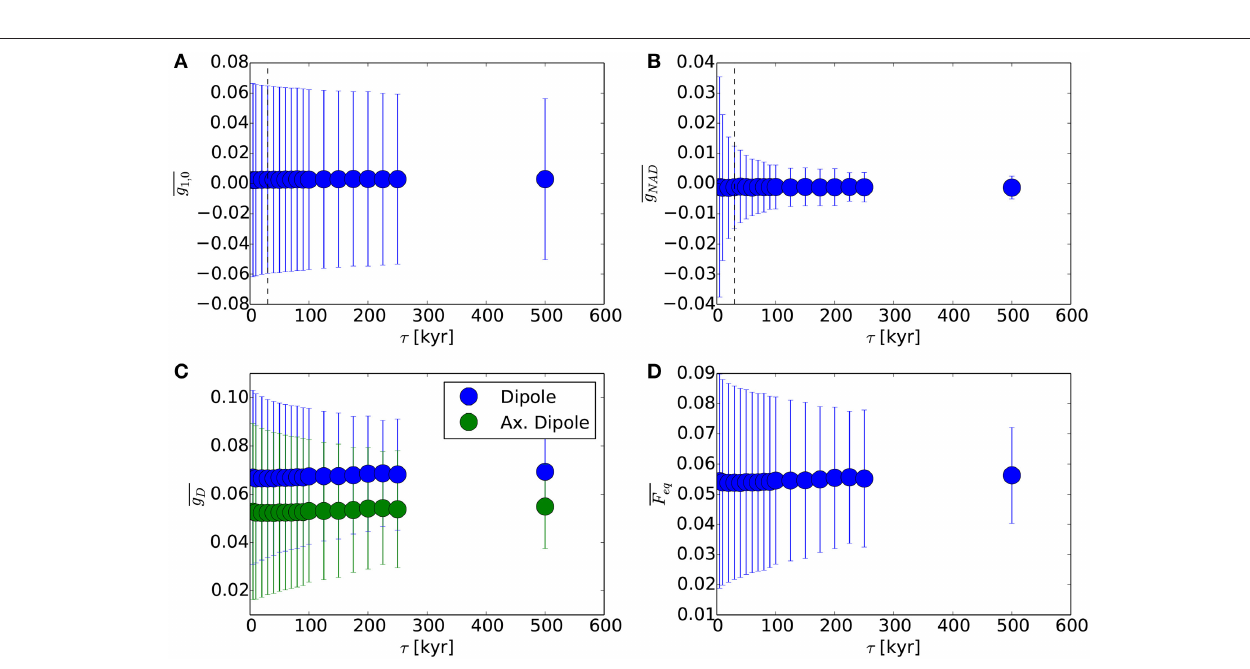
FIGURE 3 | From model 4, mean and standard deviation (error bars) of running means of dynamo statistics for a range of running average lengths τ . (A) g 1,0 . (B) Gauss coefficients of non-axial dipole g NAD from (3). (C) Dipole g D from (2). (D) Magnetic amplitude F eq at a point on the equator from (7).